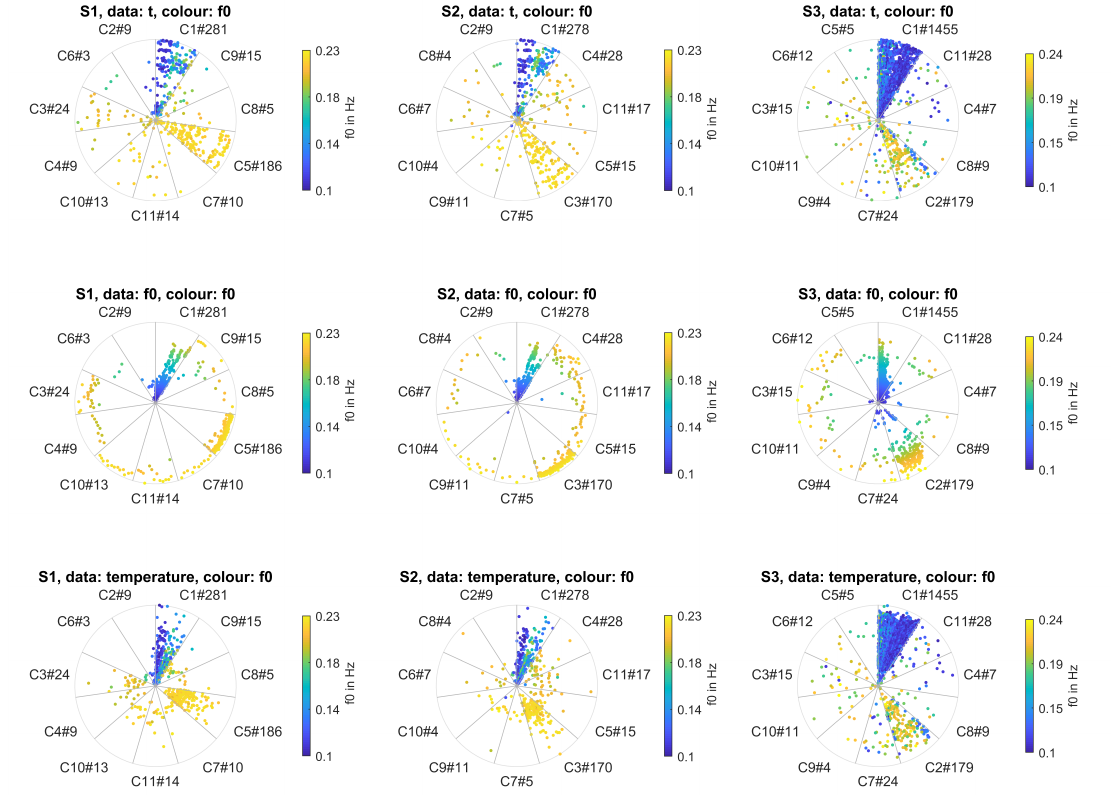
Figure 18. Visualisation of reference data for sensors S 1, S 2, and S 3: normalised reference data are displayed across the radius of each polar plot. Top: measurement time t of a 2.5-month test period for sensors S 1 and S 2 and a 7-month test period for sensor S 3. Middle: rotation frequency f 0 of 0.1Hz–0.23Hz ( S 1 and S 2) and 0.1Hz–0.24Hz ( S 3). Bottom: Temperature ranges of 1.65°C–21.0°C ( S 1), 1.9°C–21.7°C ( S 2), and − 11.5°C–32.4°C ( S 3), respectively. The colour of data points